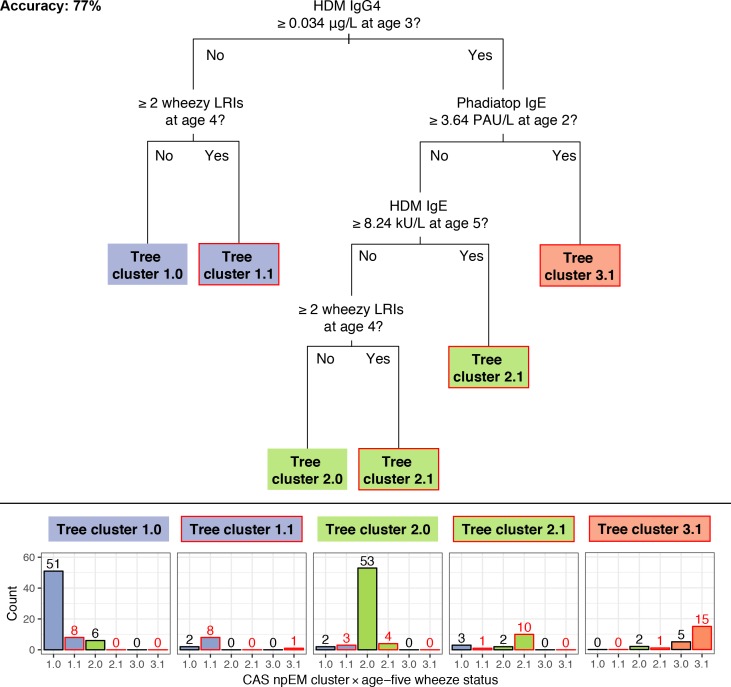
A ‘comprehensive’ decision tree generated by recursive partitioning from CAS data, given CAS npEM-derived clusters and age-5 wheezing status.CAS1.x, 2.x, and 3.x, and tree cluster 1.x, 2.x and 3.x, refer to the intersection of npEM-generated clusters and age-5 wheeze status, and their analogous decision tree cluster, respectively. The second digit (x.0 or x.1) refers to age-5 wheeze status, with ‘1’=present wheeze and ‘0’=no wheeze. Boxes, bars and digits with red outline indicate those with predicted (tree cluster) or actual (CAS npEM cluster) age-5 wheeze. Note that the tree did not predict for non-wheezing CAS3, so there is no tree cluster 3.0, and all CAS3 individuals were automatically assigned to a wheezing tree cluster.